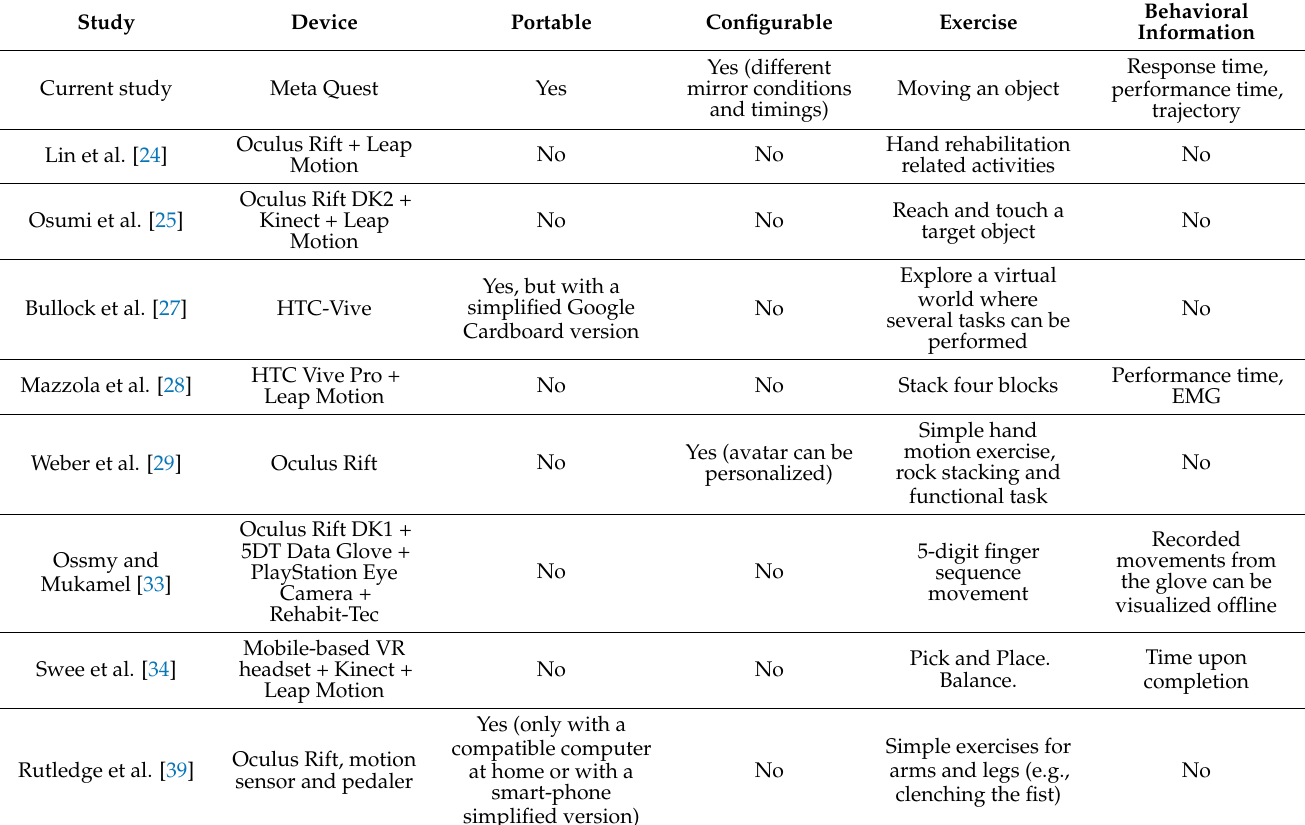
Table 3. Comparison of MVF systems developed in different studies, including the system developed in the current work. The devices used in each system are specified, indicating if the developed system is portable and configurable. The training exercise is detailed. If behavioral information is monitored, it is